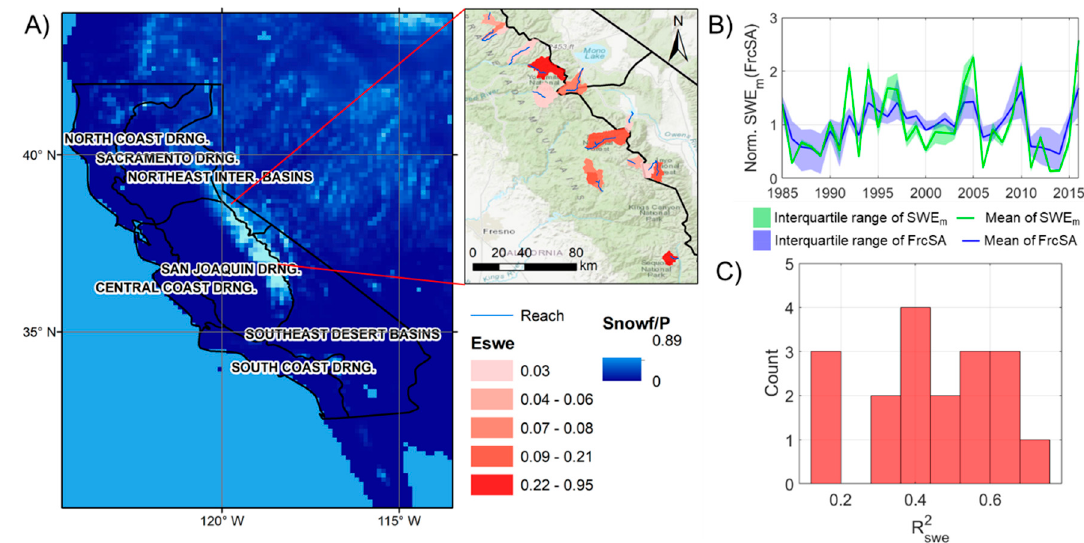
Figure 12. Mean annual fraction of snowfall in precipitation (Snow/P) in the study region and elasticity of FrcSA to maximum annual snow water equivalent (E swe ) in 16 snow-dominant catchments (Snow/P >= 0.25) ( A ), Mean and interquartile range of normalized annual mean FrcSA and annual maximum SWE (SWE m ) for the 16 catchments ( B ) and the corresponding coefficient of determination (R 2pw ) for the elasticity analysis ( C ).